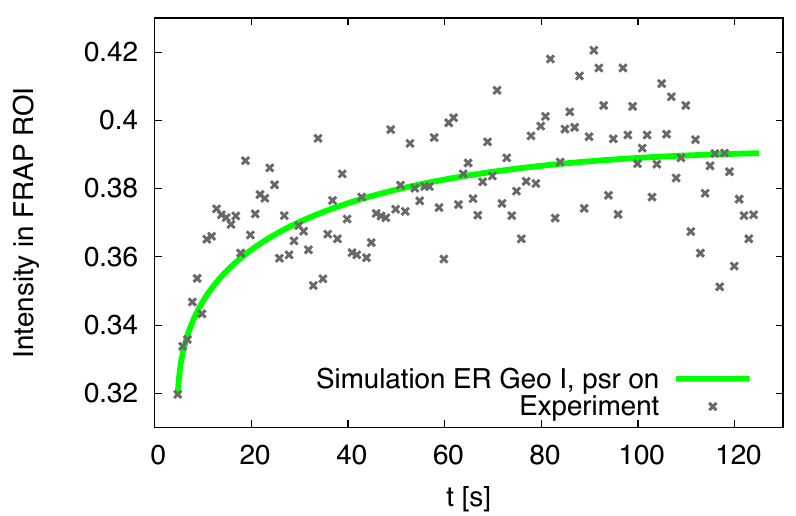
Figure 6. FRAP region intensity evaluation: experiment and simulation (computed with I of (12)), example of NS5A/OtherNSPs cell case. The curves depict the uprise of the concentration within the (bleached) FRAP ROI F for the in vitro and the in silico case. The in silico case inherits only the r N p (cid:54) = 0 case ("psr on", value cf. (11)) which models the measurement process induced signal reduction within (8). The in silico curves are that curves which arise for the estimated optimal value of D N the time series # 5 of the NS5A/OtherNSPs cell case adapted to the reconstructed ER geometry E 1